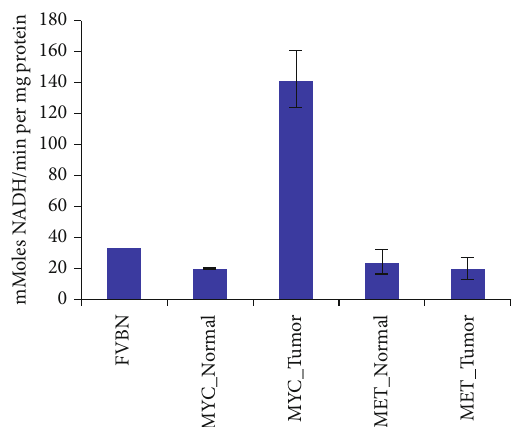
Figure 2: Glutaminase activity of HCC tumors (MYC tumor and MET tumor) and normal cells (MYC and MET) as well as normal livers from FVBN. Glutaminase activity measured in nMoles NADH/min per mg of the glutaminase protein